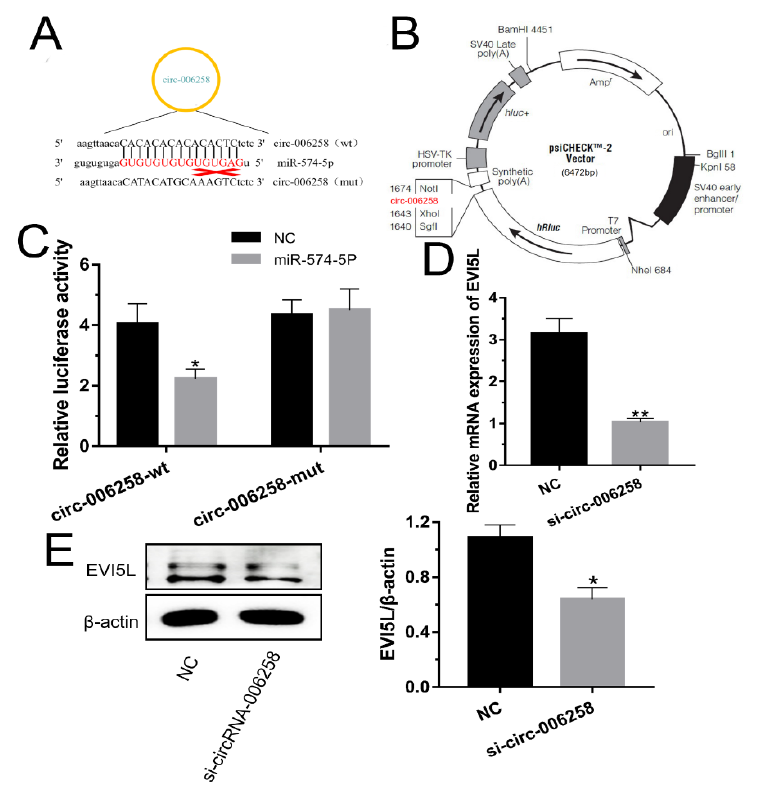
Figure 5. CircRNA-006258 promoted the EVI5L expression in GMECs. ( A ) circRNA-006258 existed complementary sequence (GCS) binding the seed sequence of miR-574-5p. ( B , C ) Contribution vector used to test the luciferase expression and the result of luciferase assay. ( D ) The analysis result concerning the mRNA expression of EVI5L by RT-qPCR. ( E ) Western blot analysis of EVI5L expression after 48 h transfectionwithcircRNA-006258andNCinGMECs. Dual-luciferasereportervectorofcircRNA-006258: wild type: WT-circRNA-006258-psiCHECK2; mutant type: MUT-circRNA-006258-psiCHECK2; NC: negative control; si-circRNA-006258: small interfering RNA. ** means significant di ff erence ( p < 0.01), * means significant di ff erence ( p <